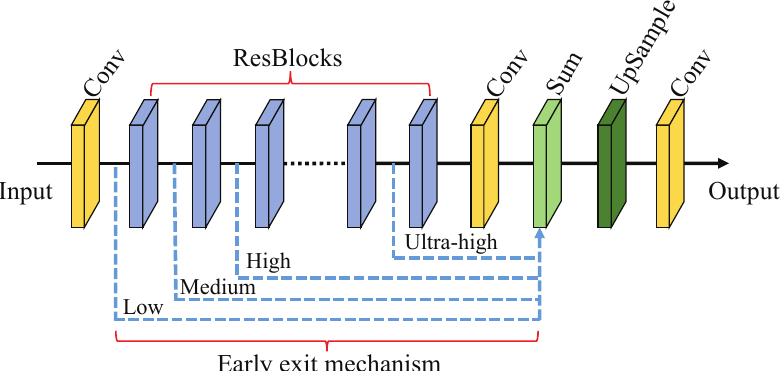
Figure 2. Multi-scale video SR models. The scalability of the SVSR model size can be achieved by the output path of the early exit mechanism [25] (i.e., the number of ResNet blocks used for